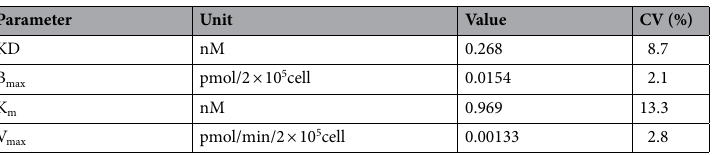
Table 2. PK parameters for the FcγRIIB-mediated binding and uptake in mouse NPC. The concentration- dependent binding and uptake profiles in mouse NPC were analyzed by the receptor-ligand binding equation and Michaelis–Menten equation,